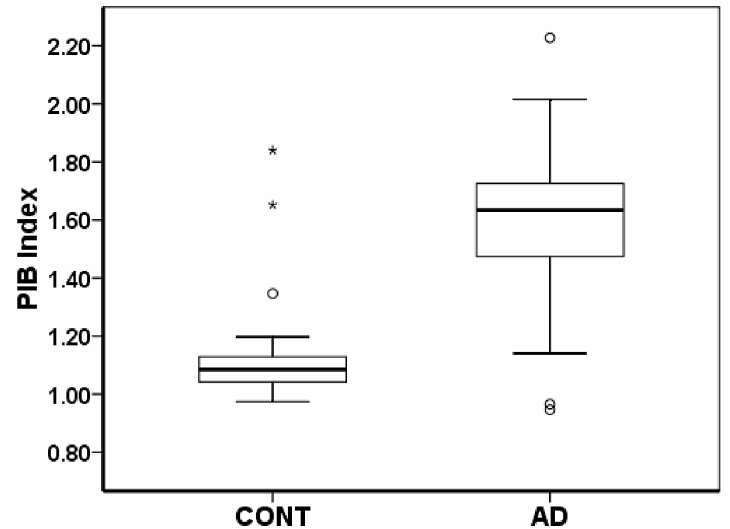
Fig. 2. PIB Index in controls and AD. Box and whisker plots represent median (line), 25 th and 75 th percentile (box) and 1.5 times interquartile range (IQR, whiskers) of PIB Index in controls recruited from the Berkeley Aging Cohort (CONT, N = 30, mean age 73.7 ± 6.7, MMSE 29.2 ± 1.0), and AD patients evaluated at the University of California San Francisco (N = 38, age 68.4 ± 10.6, MMSE 22.8 ± 4.5). Outliers (PIB Index between 1.5 and 3 IQR) are denoted by a circle and extreme outliers (PIB Index greater than 3 IQR) by an asterisk. PIB Index represents mean distribution volume ratio (DVR) in frontal, parietal, lateral temporal and cingulate cortex. The control with the second highest PIB Index is featured in Fig. 1, middle